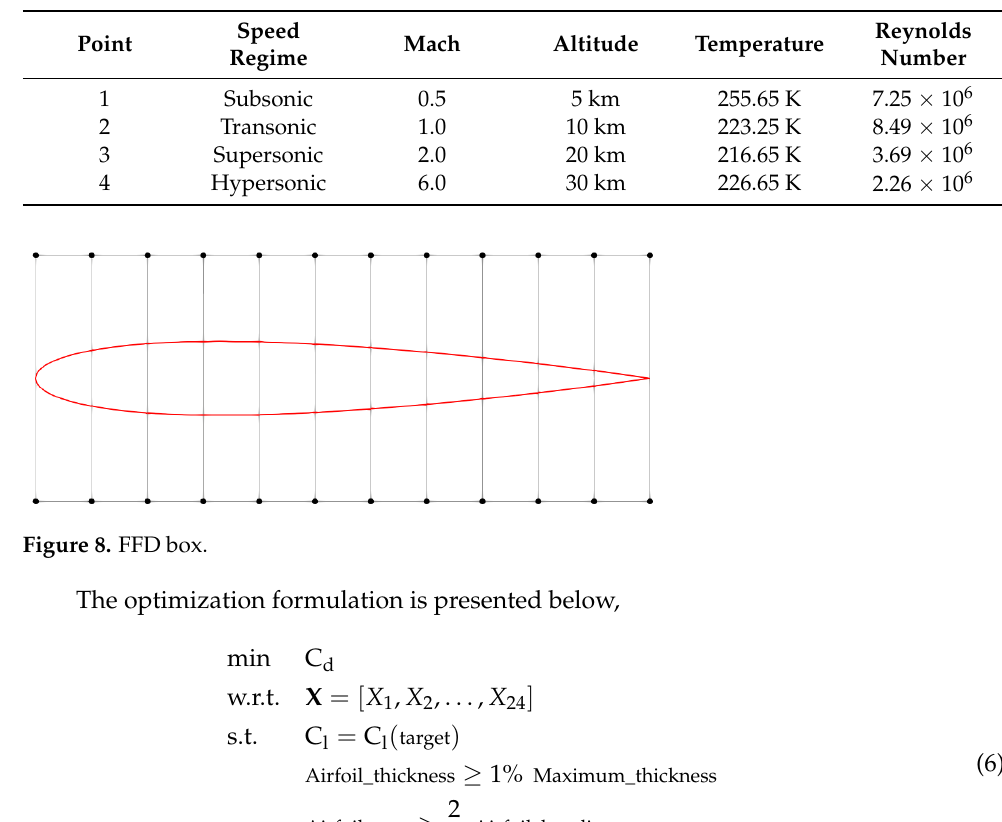
Table 2. Main information regarding selected points.